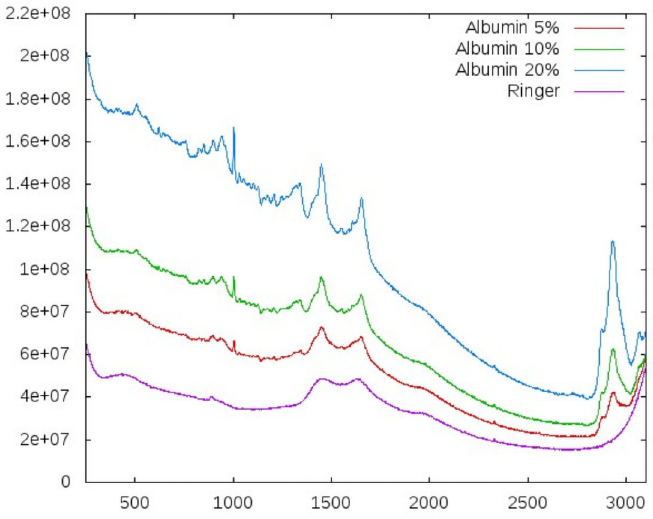
Fig 6. Comparing different albumin concentrations in solution. The spectrum for Ringer solution is plotted as reference. Shown are the unfiltered, raw spectra. The increase of both fluorescence and Raman signal are clearly visible. Exposure 172